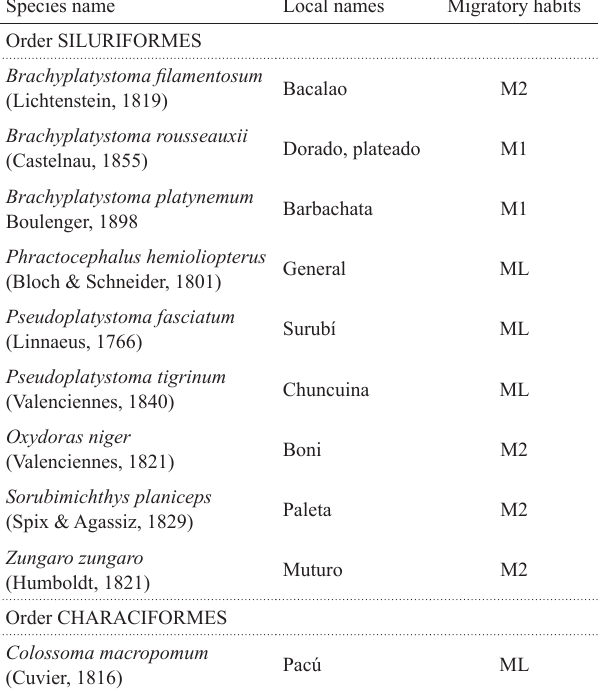
Tab. 1. Fish species caught in the Ichilo River recorded by fishers of Puerto Villarroel. Within each order species are listed in alphabetic order. M1=Long-distance longitudinal migration; M2=Intermediate distance longitudinal migration, ML=Intermediate distance longitudinal and lateral migration (following Barthem, Goulding,